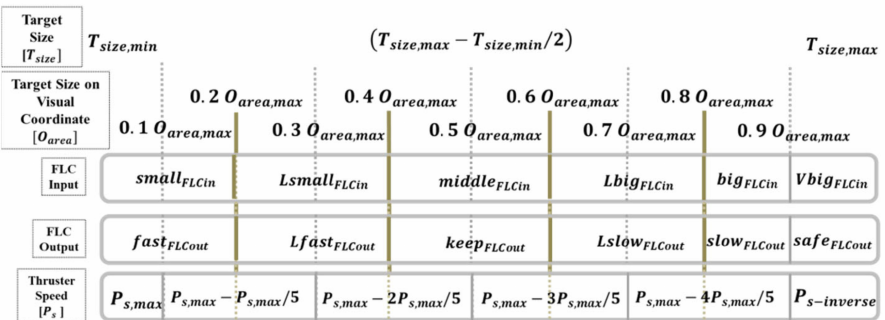
Figure 10. Relationship between the target’s size within the image coordinates and the FLC propeller revolution